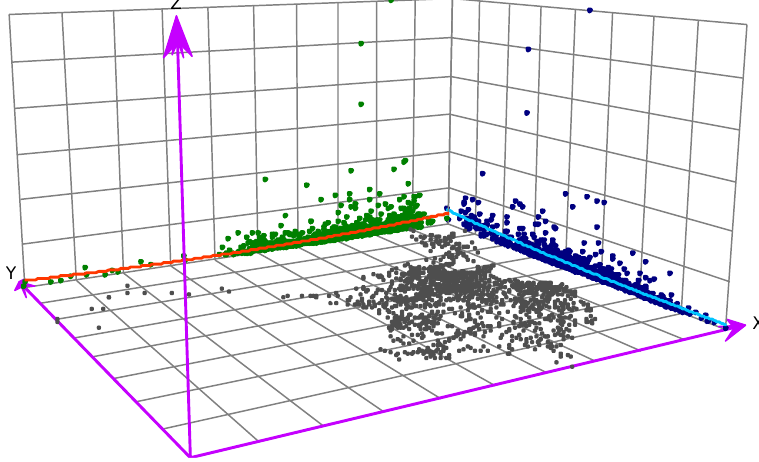
Figure 9. Spatial distribution trends of cities in China during the TCE.